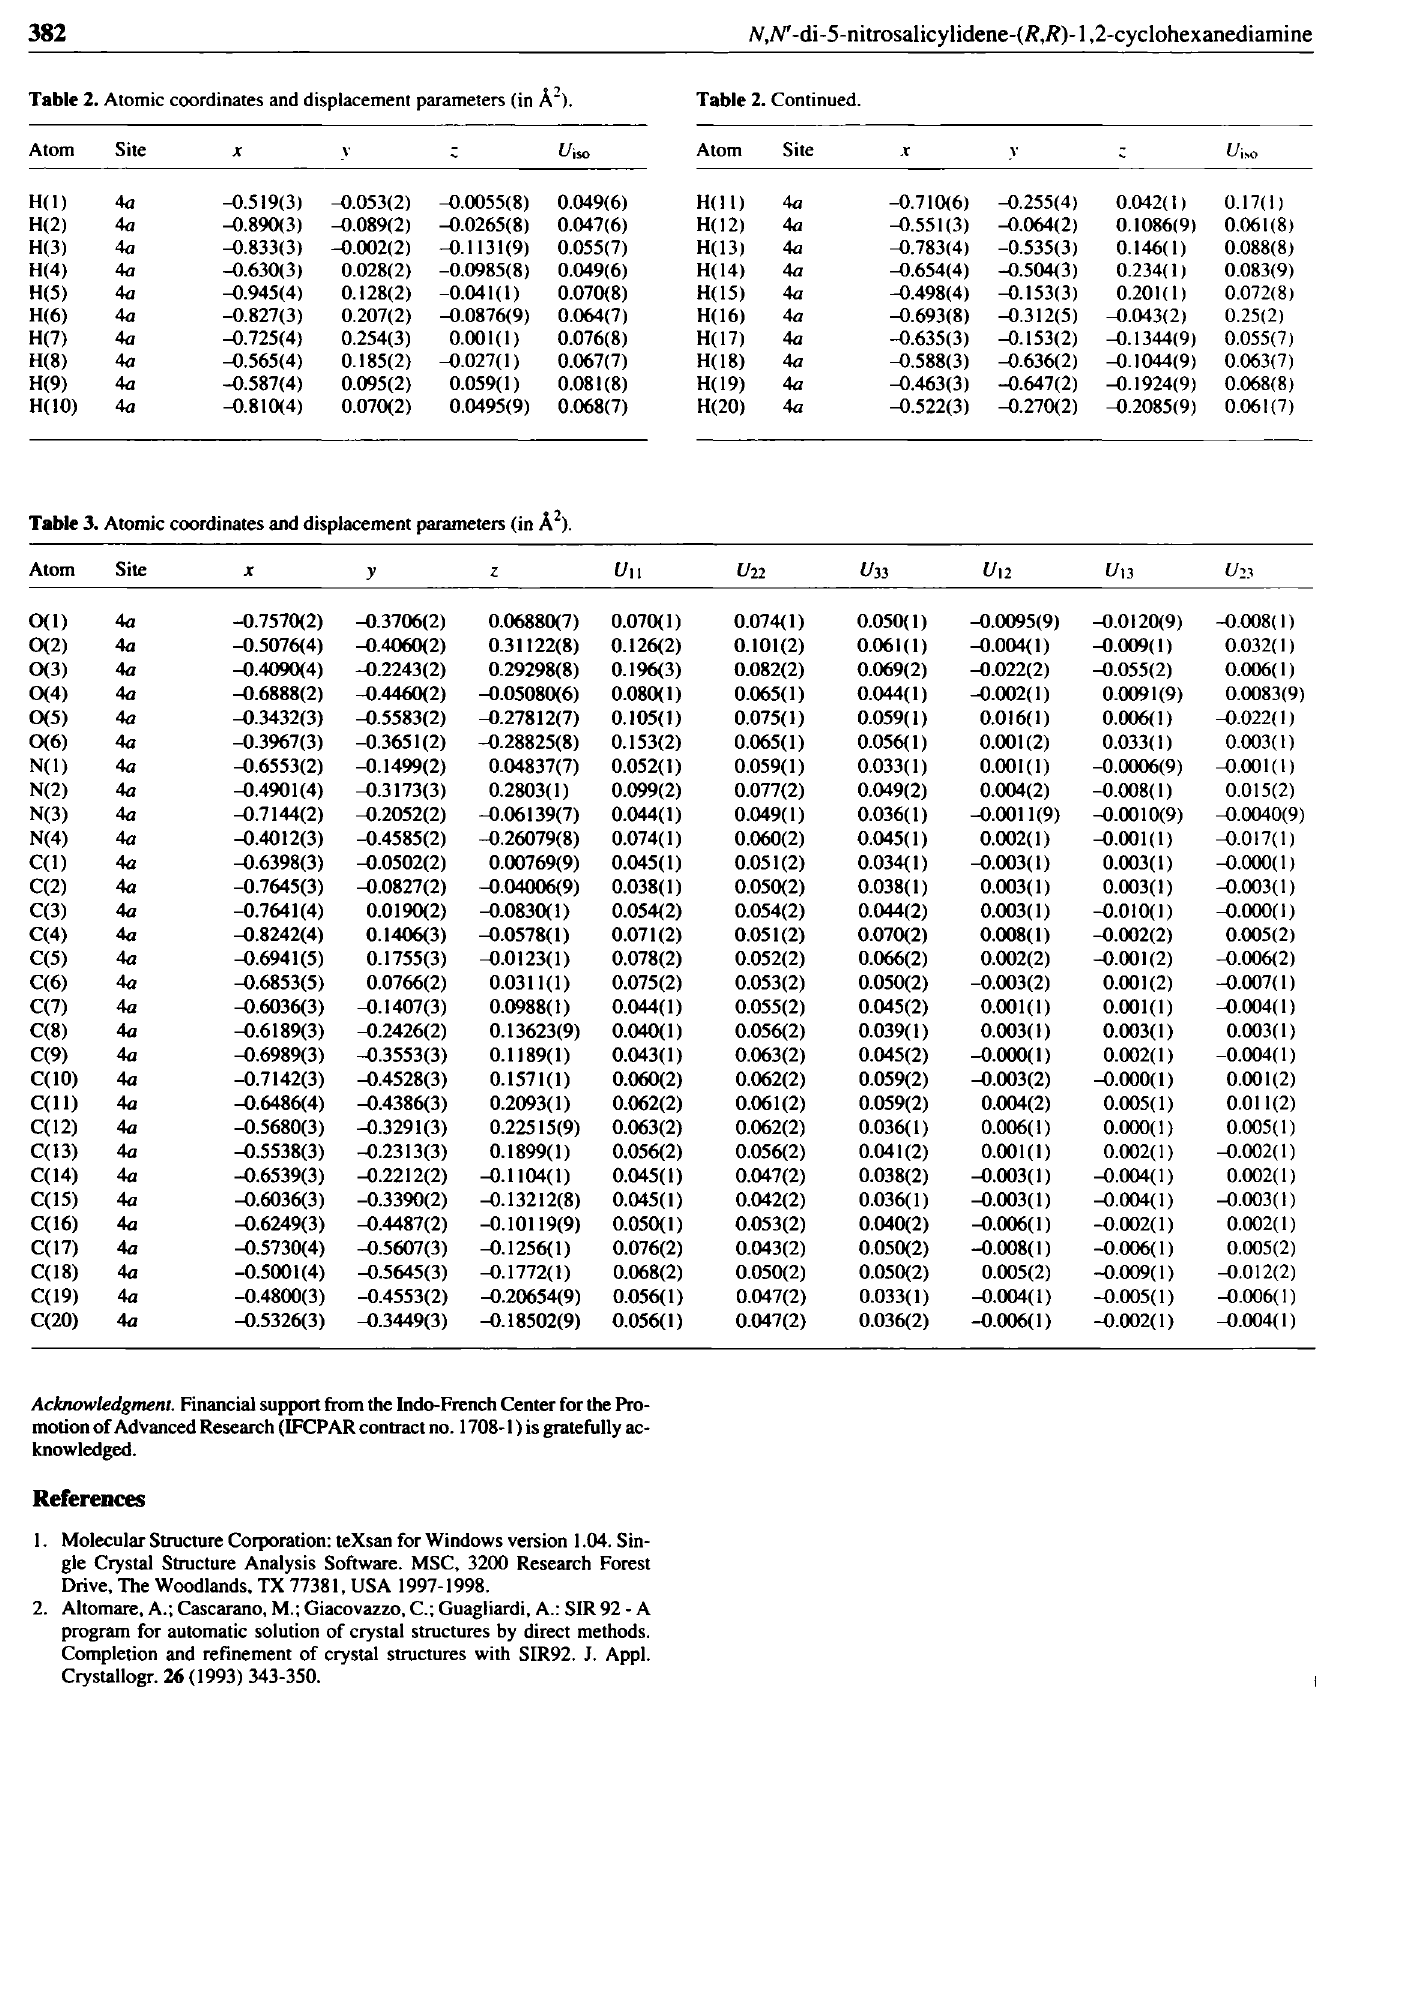
Table 3. Atomic coordinates and displacement parameters (in A 2